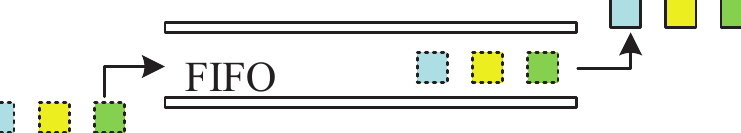
Figure 10. Default queuing disciplines in